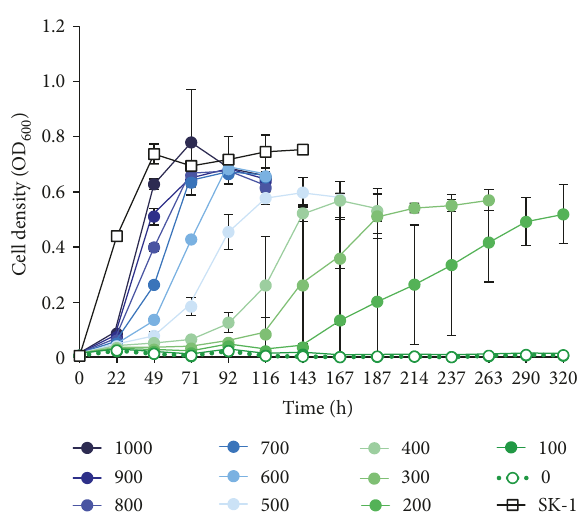
Figure 7: Growth curve of the argD deletion mutant SK-5. Wt (SK-1) and Δ argD (SK-5) were cultivated in XTU liquid medium with or without agmatine at 75 ° C with shaking. Closed circles: SK-5 with agmatine (100 – 1000 μ g/mL); open circles: SK-5 without agmatine; open squares: SK-1 without agmatine. Error bars represent the standard deviation from three independent